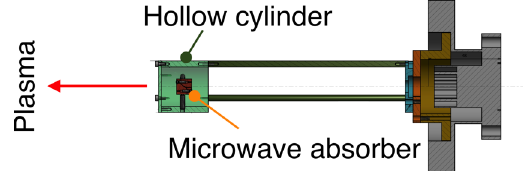
Fig. 1 : Installation of the microwave absorber mounted on an ICF 114